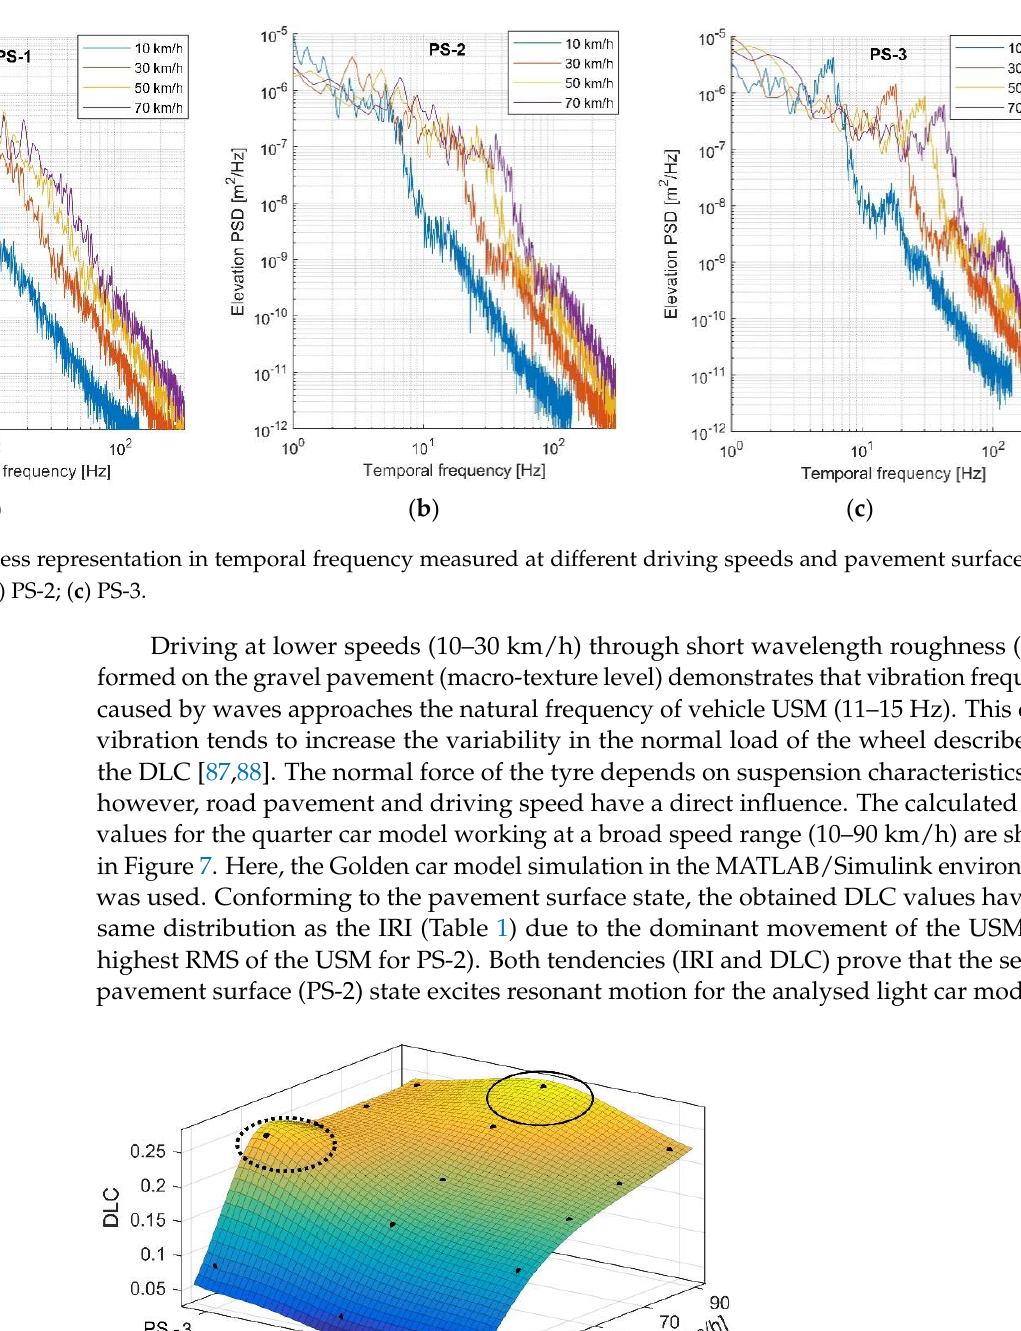
state (Figure 6): a peak for 10 km/h at 5–6 Hz, a peak for 30 km/h at 15–18 Hz, a peak for